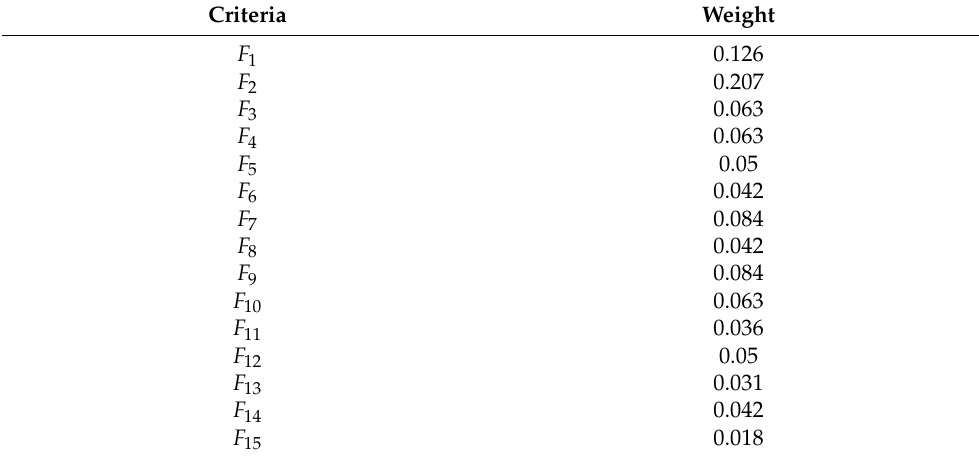
Table 13. The weights of criteria.